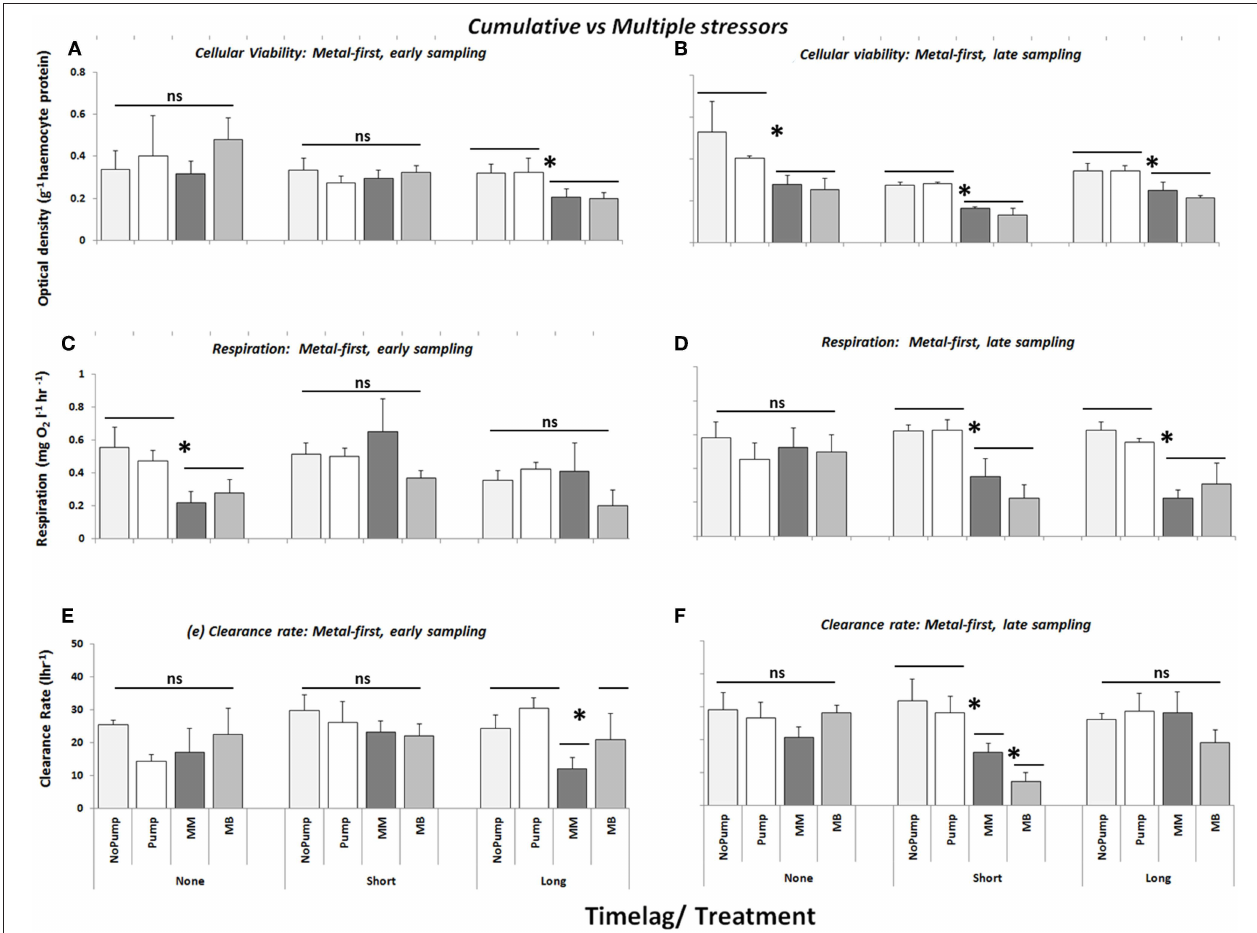
FIGURE 2 | Cellular viability (optical density g − 1 haemocyte protein), respiration (mg O 2 l − 1 hour − 1 ) and clearance rate (l/hour) of mussels/mussel assemblages at Malahide marina with metal as the primary contaminant in cumulative (MM) and multiple stressor treatments (MB), M = Copper and B = Biocide. Also shown are the control treatments: “No Pump” (un-manipulated control) and “Pump” (procedural control). All stress treatments were delivered with three time-lag treatments (None, Short, and Long) between the arrival of the first stress event and the second stress event and were sampled directly after dosing (Early– A,C,E ) and 2 weeks after dosing (Late– B,D,F ) ( n = 3). Asterisks indicate significant differences between individual and/or groups of treatments.